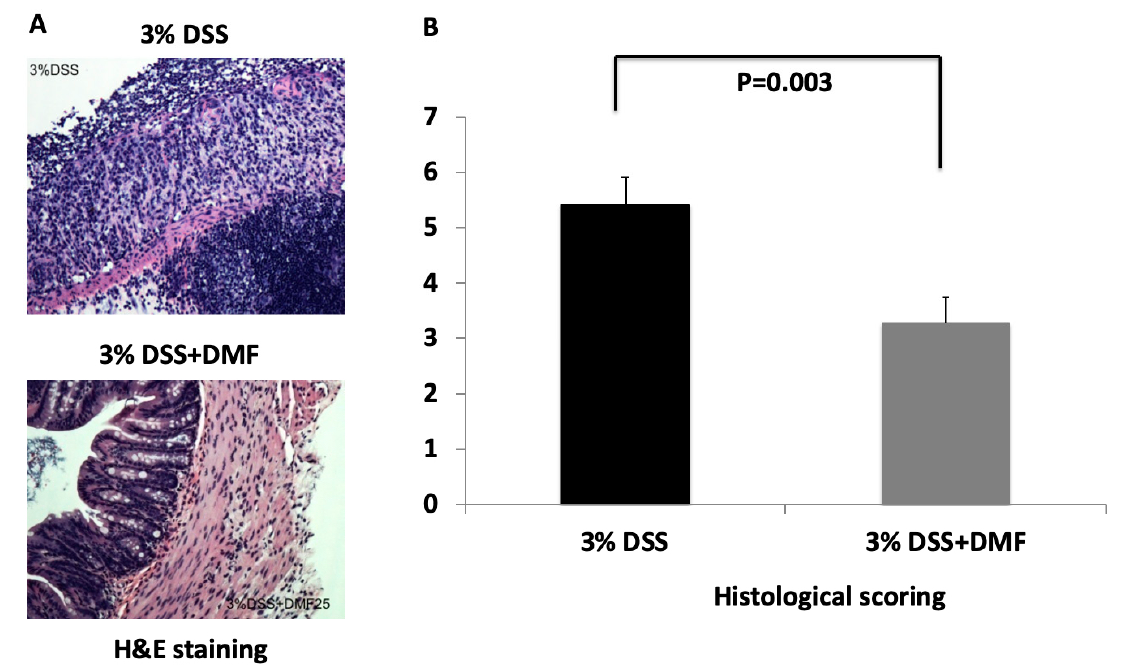
Figure 4. Histopathological examination of colon tissues from mice given 3% dextran sulfate sodium (DSS) and 3% DSS+ dimethyl fumarate (DMF) (25 mg/kg, twice daily). ( A ) Hematoxylin and eosin (H&E) ‐ stained histology of colon tissues from DSS ‐ induced colitis mice, with and without DMF treatment, magnification: ×200. Histopathological analysis of colon tissues of mice without DMF treatment showed a substantial loss of epithelium and increase in the infiltration of inflammatory cells, whereas colon tissues from mice treated with DMF had a marked reduction in inflammatory cell infiltration. ( B ) Histology damage scores of colon tissues from DSS ‐ induced colitis mice, with and without DMF treatment. Data represent the mean ± SEM. 3.2. Effects of DMF Treatment on Protein Expression of Antioxidant Enzymes in Colon Tissue